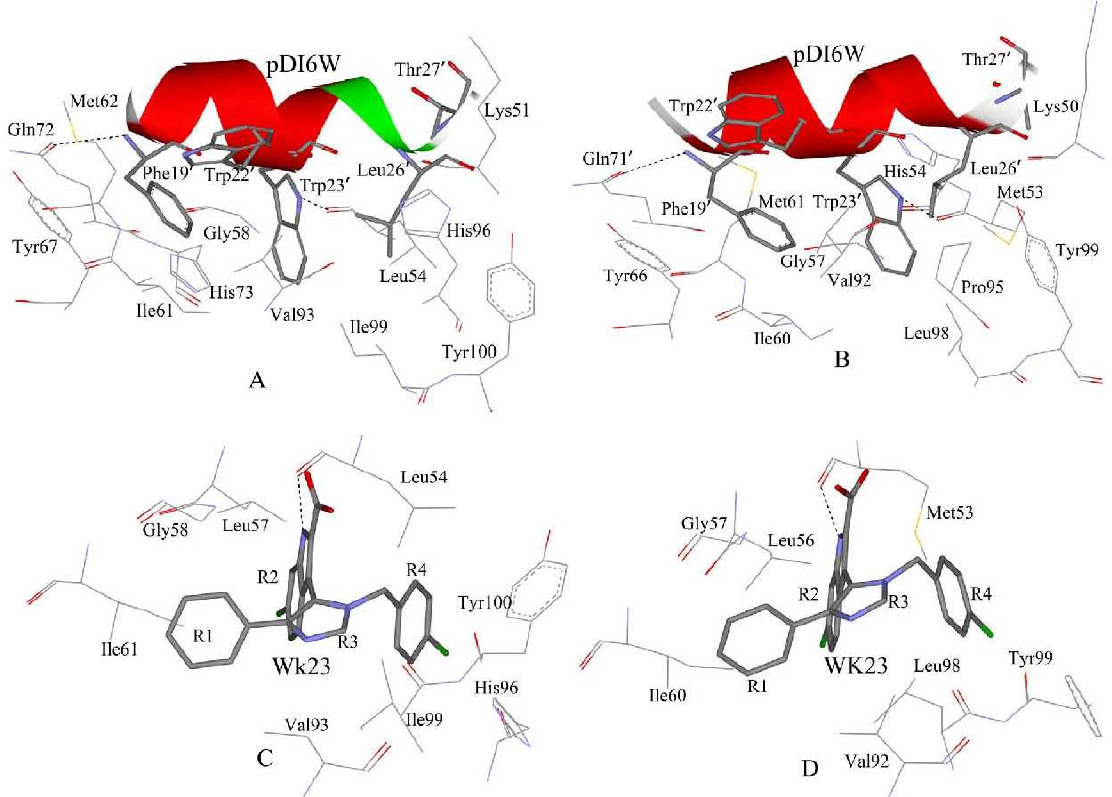
Figure 7. Geometries of key residues, which produce some favorable interactions with two inhibitors, are plotted in the complexes according to the lowest-energy structure from the MD trajectory. ( A ) pDI6W-MDM2 complex; pDI6W-MDMX complex; ( C ) WK23-MDM2 complex; and ( D ) WK23-MDMX complex. The dashed line represents a hydrogen bond between the inhibitor and